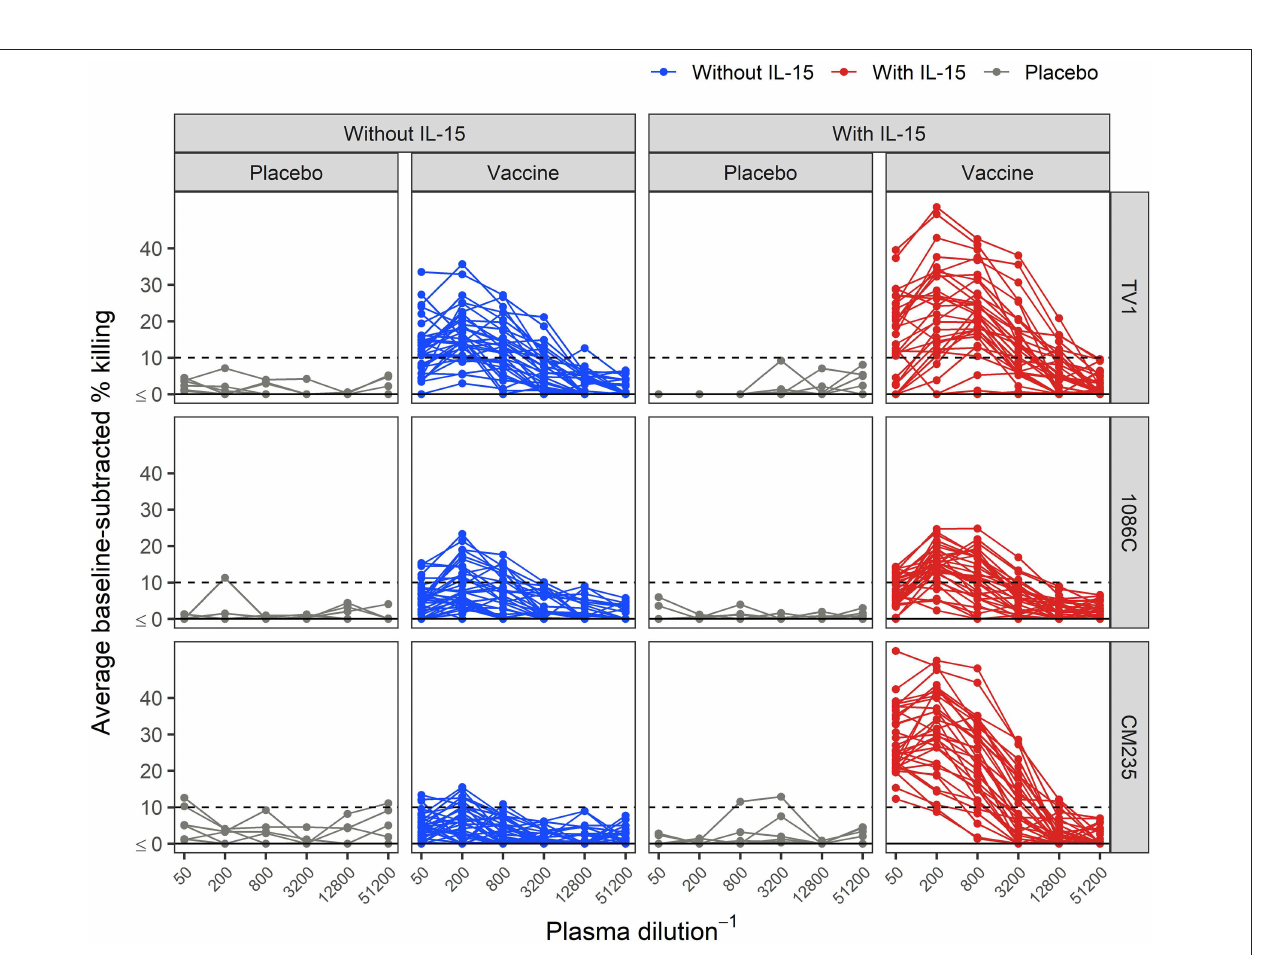
FIGURE 6 | Average baseline-subtracted % killing curves for placebo and vaccine recipients, in the presence and absence of IL-15. Target cells were infected with the TV1, 1086C, or CM235 IMC. Results from placebo samples are shown in gray. The black dashed line is at 10%, the positivity threshold for baseline-subtracted %